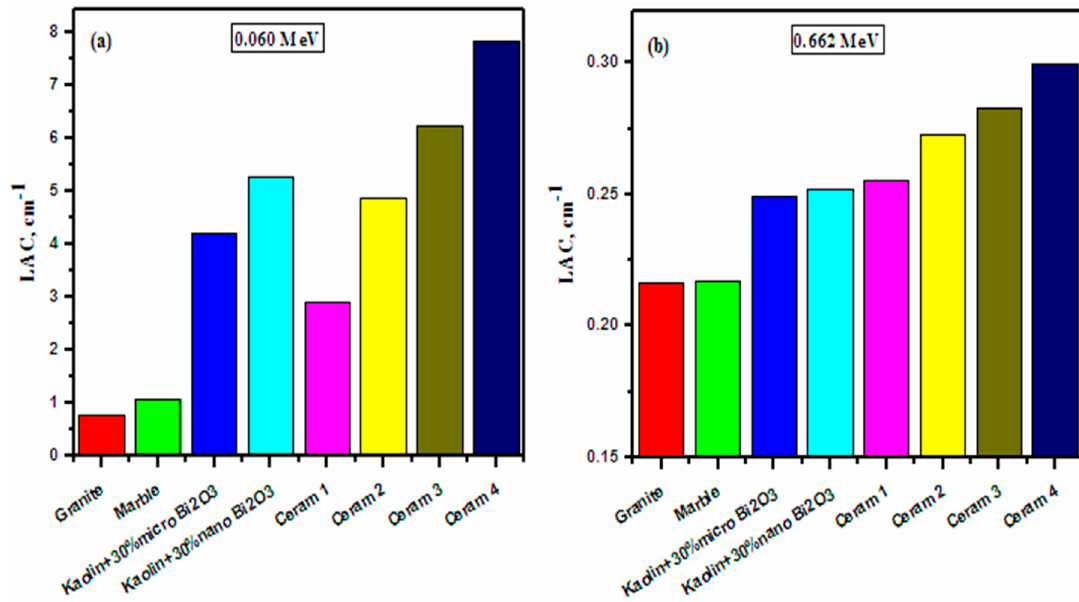
Figure 10. Comparison between the LAC of the prepared ceramics with other